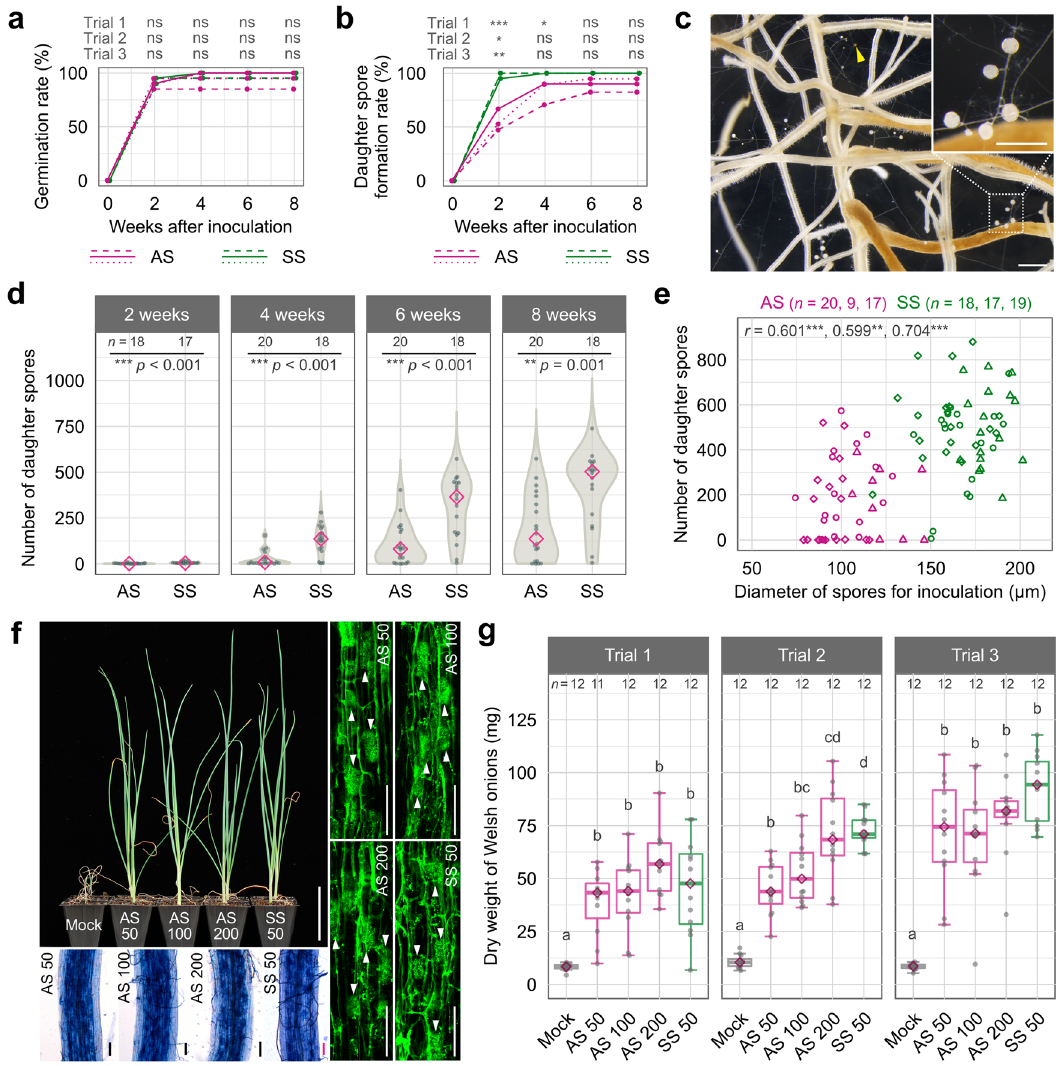
Fig. 3 Inoculation of asymbiotically generated spores to plants. a – e Inoculation of asymbiotically generated spores (AS) and symbiotically generated spores (SS) to carrot hairy roots grown on modi fi ed M medium. AS and SS of R. clarus were prepared by asymbiotic culture in TGM medium and in vitro monoxenic culture, respectively. Time course of germination rate ( a ) and daughter spore formation rate calculated as a percentage of spores that produce daughter spores after the successful colonisation relative to germinated spores ( b ). Dashed, solid and dotted lines indicate trials 1 – 3, respectively. Asterisks above graphs indicate signi fi cant differences between treatments in each time point using Fisher ’ s exact test with Bonferroni correction. *** p < 0.001; **0.001 ≤ p < 0.01; *0.01 ≤ p < 0.05; ns not signi fi cant. p -values are described in Supplementary Data 2. c Daughter spore formation in monoxenic culture, in which carrot hairy roots were inoculated with a single (arrowhead). Bars = 500 µ m. d Time course of daughter spore formation after inoculation of AS or SS. Diamonds indicate medians. Asterisks above graphs indicate signi fi cant differences among treatments using Wilcoxon rank-sum test. This is a representative data of all three trials, another two data are described in Supplementary Data 1. e Correlation between the diameter of spores inoculated into carrot hairy roots and numbers of daughter spores at 8 weeks after inoculation. Circles, triangles and diamonds indicate trials 1 – 3, respectively. r values are Pearson ’ s correlation coef fi cient. The three values are trials 1 – 3, respectively from the left. *** p < 0.001; **0.001 ≤ p < 0.01. p -values are described in Supplementary Data 2. f , g Inoculation of AS and SS to Welsh onions in pots. f Growth and root colonisation of Welsh onions inoculated with AM fungi at 8 weeks after inoculation. Numbers following AS or SS are the number of spores for inoculation. The appearance of Welsh onions (upper left, bar = 5 cm). AM fungal structures in roots stained with trypan blue (bottom left, bar = 100 µ m) and wheat germ agglutinin conjugated with Oregon Green 488 (right, bars = 100 µ m). Arrowheads show arbuscules. g Dry weights of Welsh onion shoot at 8 weeks after inoculation. The upper and lower side of boxes show the 25 and 75% quantiles, bars inside boxes indicate medians. Whiskers indicate 1.5 times the interquartile range. Different letters indicate signi fi cant differences among treatments in each trial using Wilcoxon rank-sum test with Bonferroni correction, p <